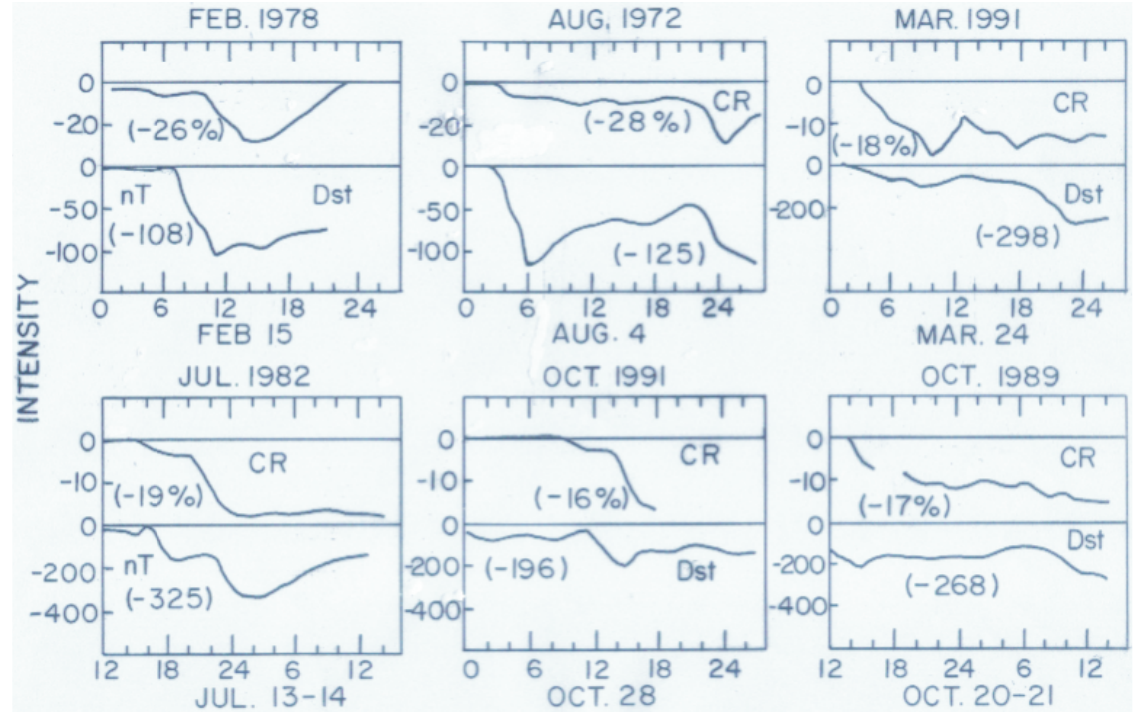
Fig. 8. Same as Fig. 7, for the six largest FDs 15 February 1978, 4 August 1972, 24 March 1991, 13–14 July 1982, 28 October 1991 and 20–21 October